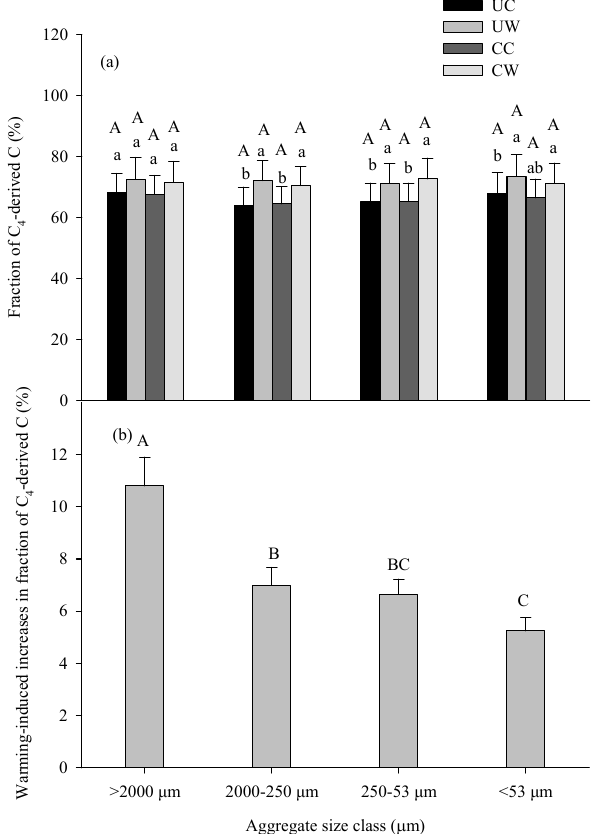
Fig. 3. Fig. 3. Fraction of C 4 -derived C of aggregate size classes under four treatments after nine years of warming and clipping (a) , and warming-induced increases in the fraction of C 4 -derived C of ag- gregate size classes in warmed soils (b) . Vales followed by a dif- ferent lowercase letter are significantly different within aggregate size classes among treatments. Values followed by a different cap- ital are significantly different among aggregate size classes under